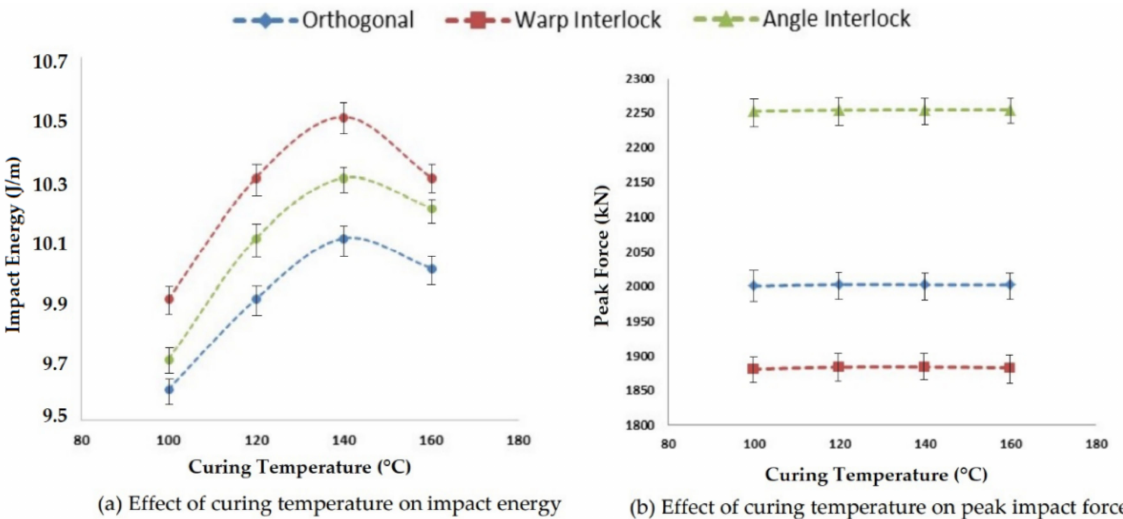
Figure 14. Effect of curing temperature on the impact properties of 3D woven